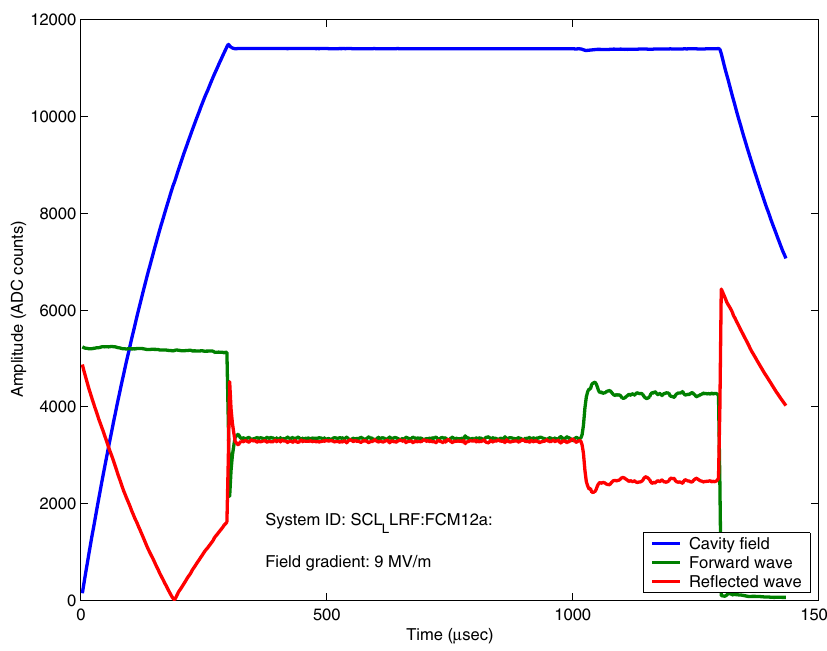
FIG. 8. (Color) A full view of the FCM transient response to a 10 mA, 300 (cid:1) s beam pulse on superconducting cavity SCL-12a. The beam loading occurs at the end of the rf pulse.